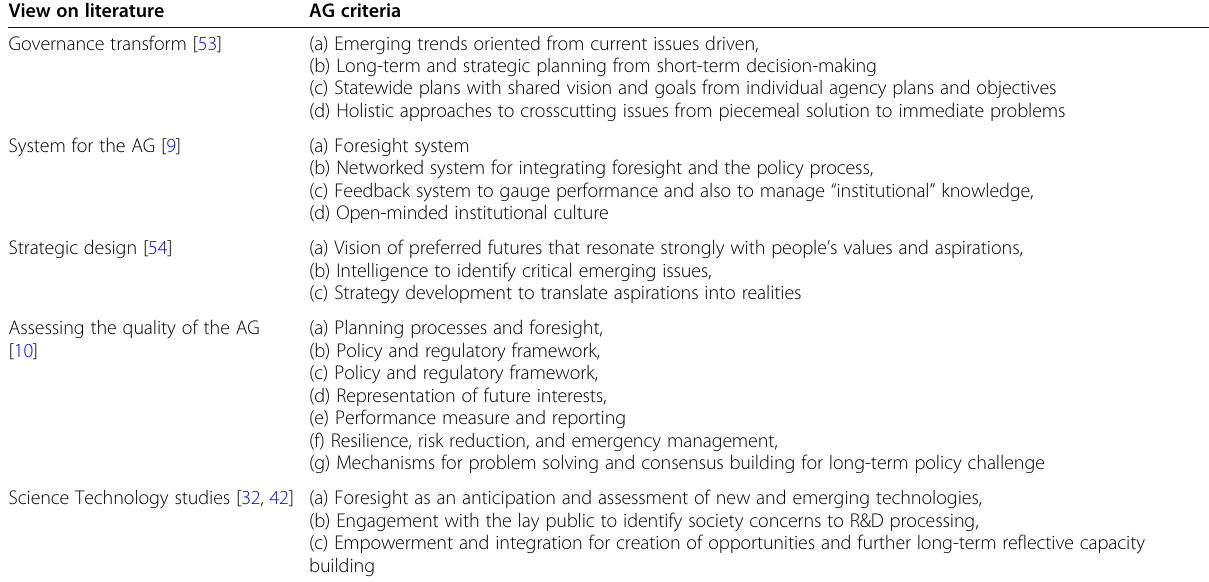
Table 1 Anticipatory governance framework with criteria in key literature View on